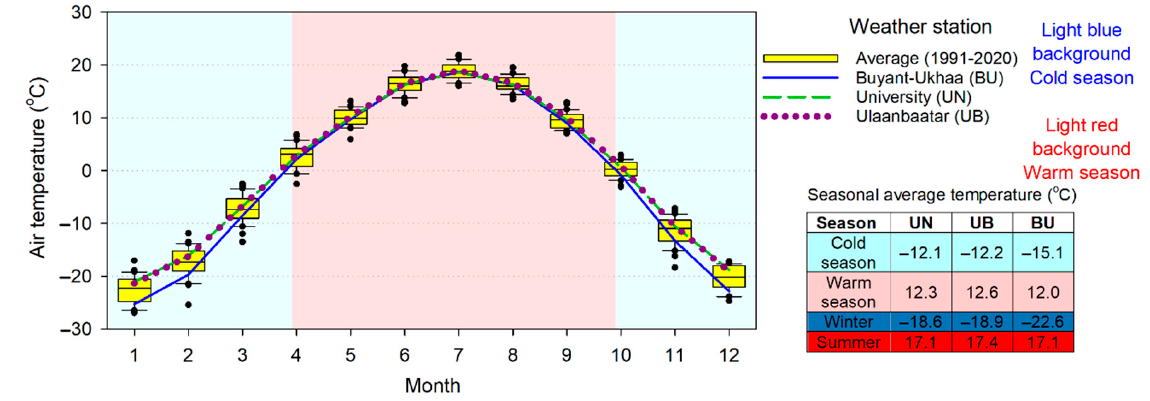
Figure 4. Seasonal variations in air temperature of Ulaanbaatar city.